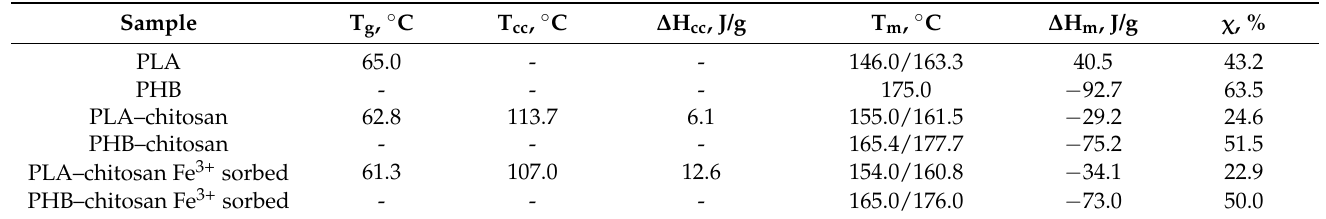
Table 2. DSC parameters of thermal transitions observed in PLA, PHB, and their compositions with chitosan (Supplementary Materials: Calculation of thermophysical parameters obtained by